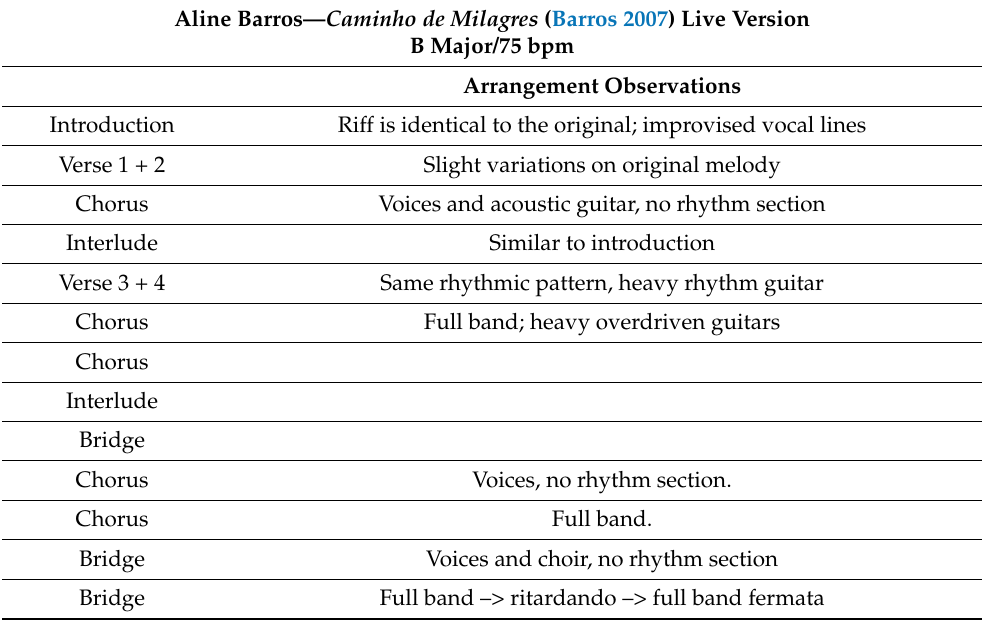
Table 3. Form and arrangement outline of Aline Barro’s version of “Poder pra salvar”.